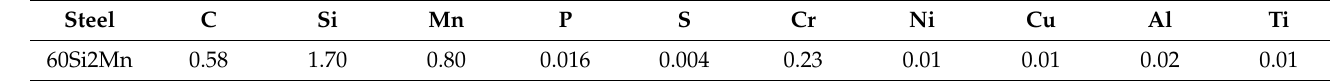
Table 1. Chemical composition of steel 60Si2Mn.